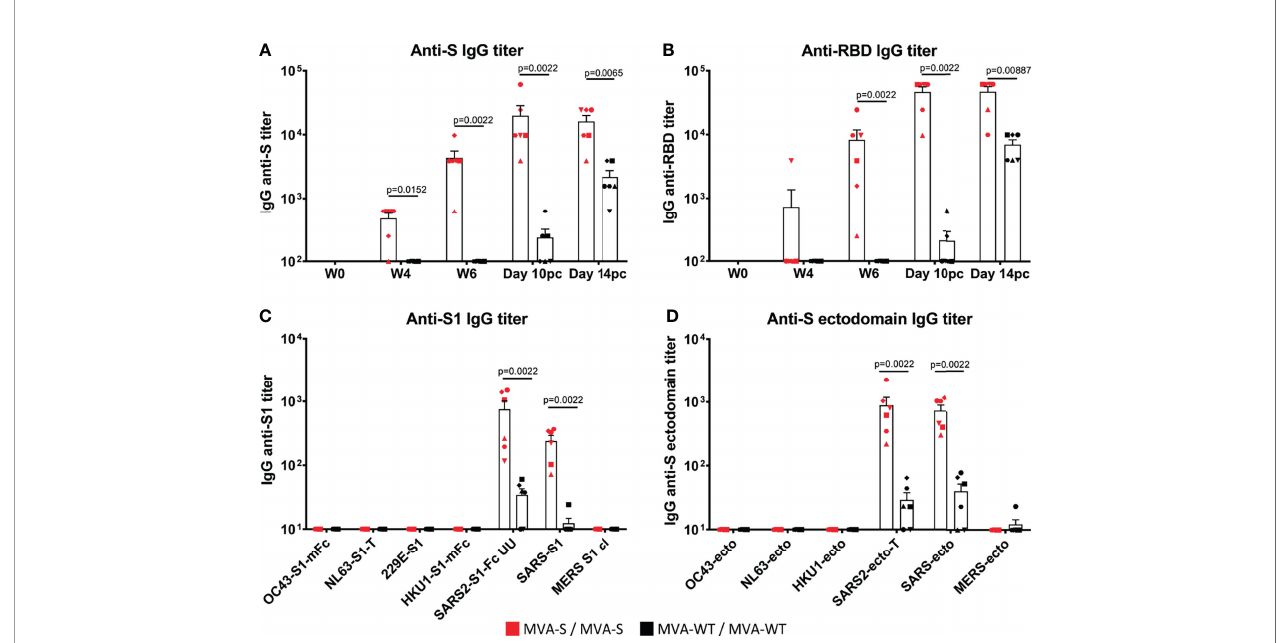
FIGURE 2 | MVA-S elicited SARS-CoV-2-speci fi c binding IgG antibodies. ELISA IgG antibody titers to SARS-CoV-2 S protein (A), and RBD (B) in time, and IgG antibody titers at 14 days post-challenge as measured by array analysis to S1 domain (C) and ectodomain (D) of the S protein from several coronaviruses (common cold a [229E, NL63] or b [OC43, HKU1] coronaviruses; SARS-CoV-2, SARS-CoV-1, and MERS) of MVA-S (red) and MVA-WT (black) immunized macaques. Each animal is represented by a symbol. Mean and SEM are shown in columns for each group of animals. Signi fi cant differences between the groups are indicated in the graph by a horizontal line and p-value (Mann – Whitney